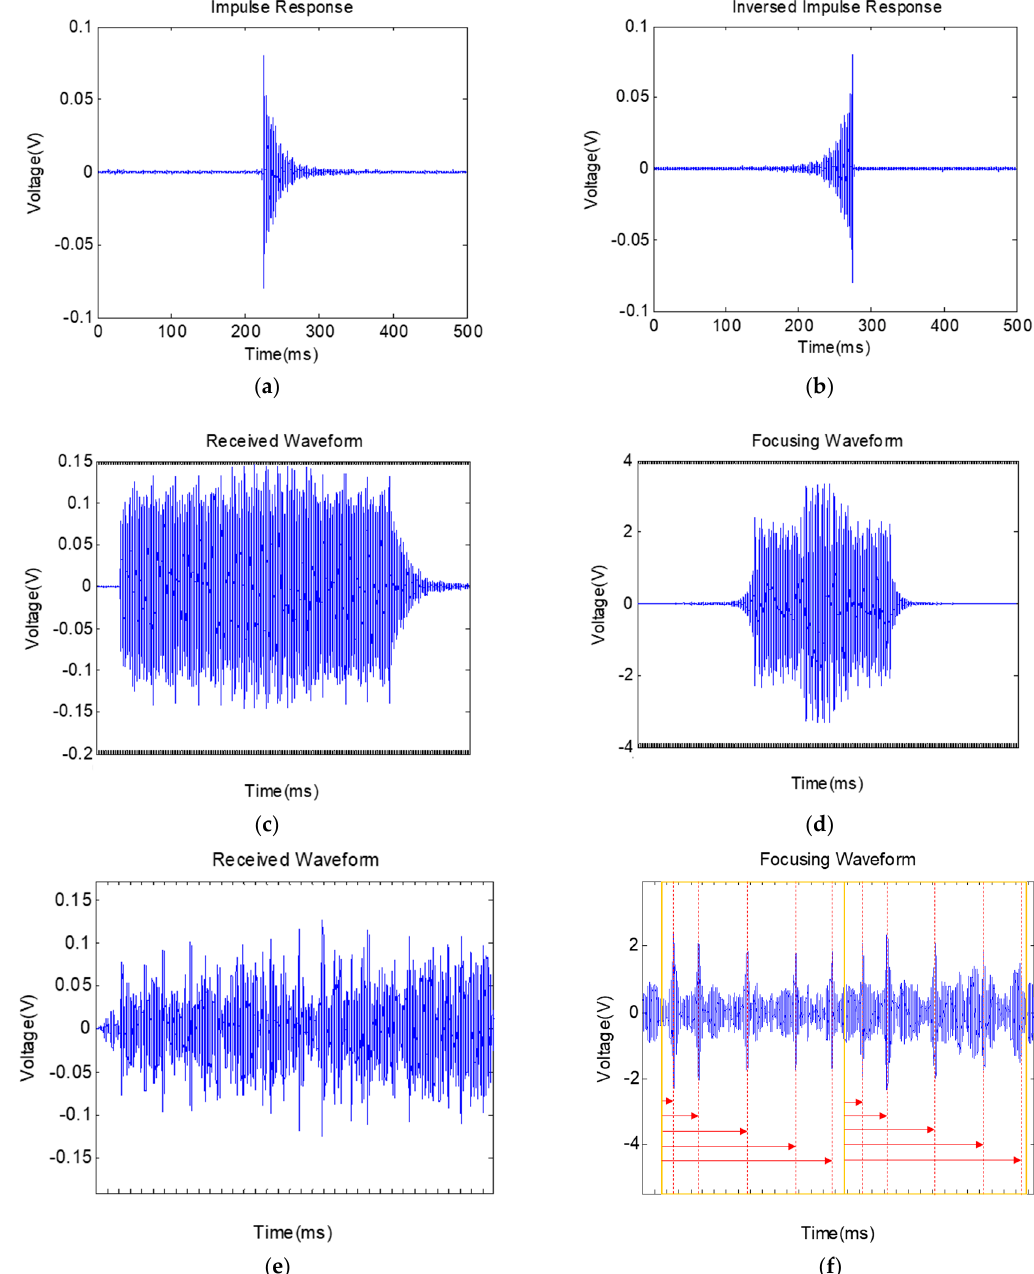
Figure 14. Experimental results: ( a ) impulse response; ( b ) time-inversed impulse response; ( c ) received signal; ( d ) focused waveform; ( e ) zoomed-in figure of received signal; ( f ) zoomed-in figure of the focused waveform.